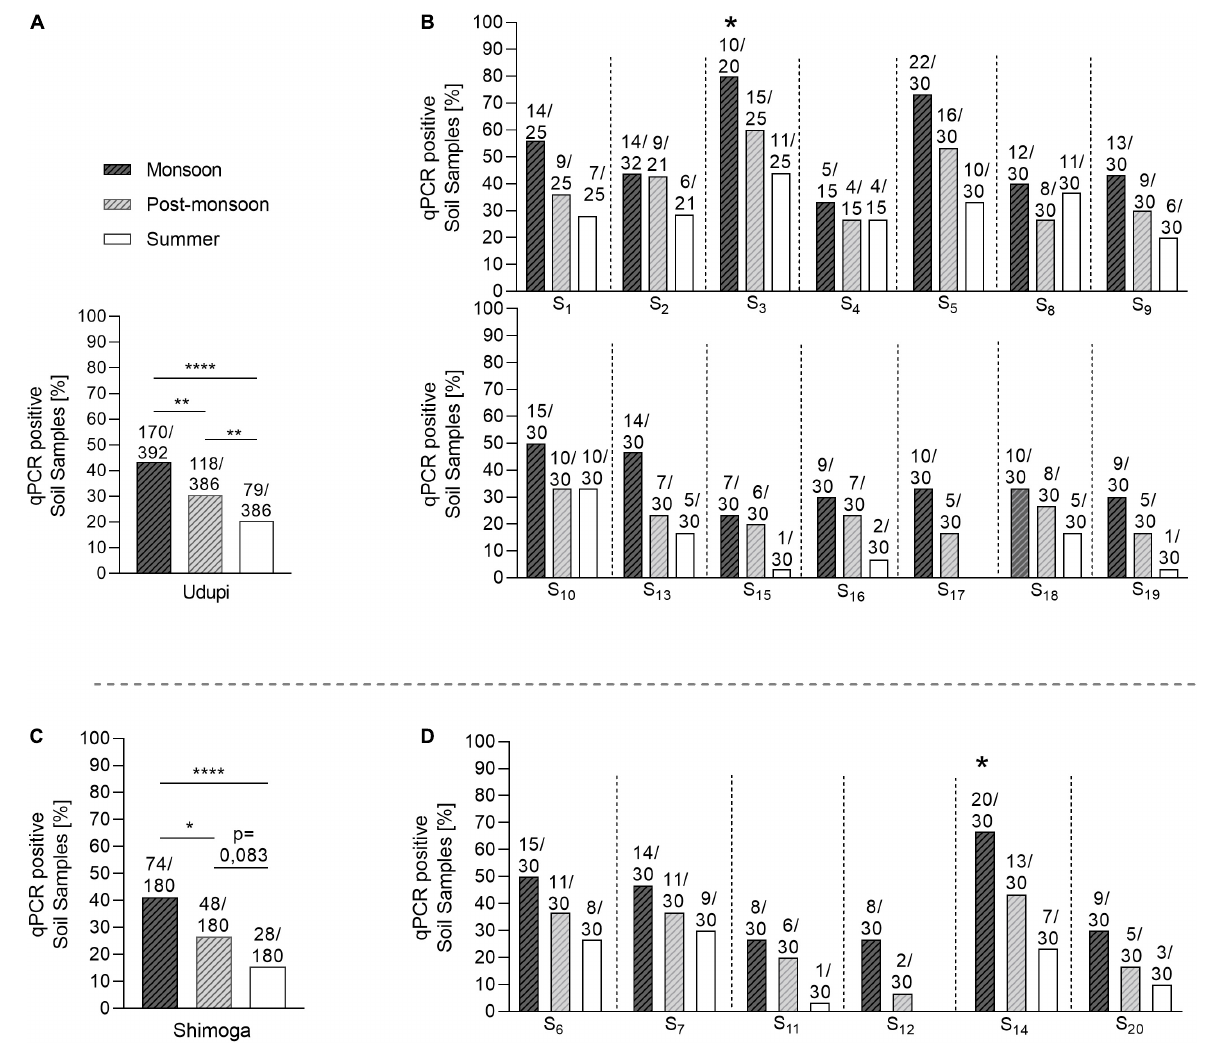
FIGURE 4 | Seasonal prevalence of B. pseudomallei qPCR-positive soil samples from Udupi and Shimoga districts. (A) B. pseudomallei positive detected samples collected in Udupi in different seasons. (B) Percentage of positive soil samples detected in Udupi separated by sites. (C) B. pseudomallei positive samples collected in Shimoga in different seasons. (D) Percentage of positive detected soil samples in Shimoga separated by sites. The two starlets above the bars of site S3 and S14 mark culture positive sampling sites (Fisher’s exact test: * p < 0.05, ** p < 0.01, **** p <